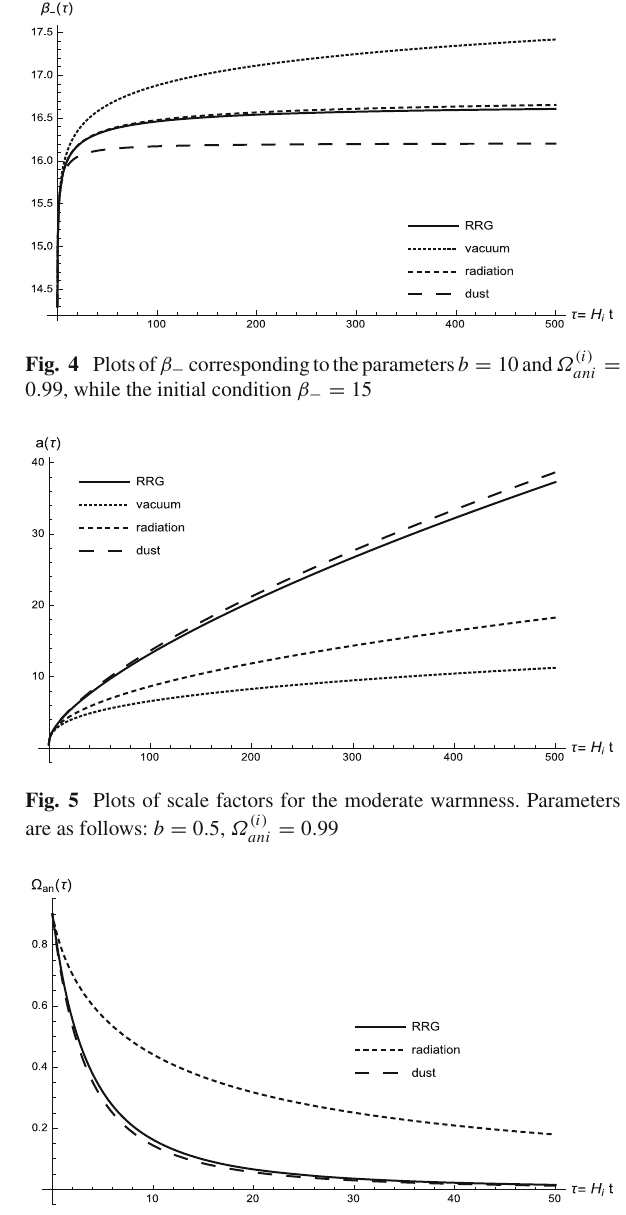
= ani Fig. 6 Plots of Ω ani (τ) for the moderate warmness. Parameters are as ( i ) = 0 . follows: b = 0 . 5, Ω ani